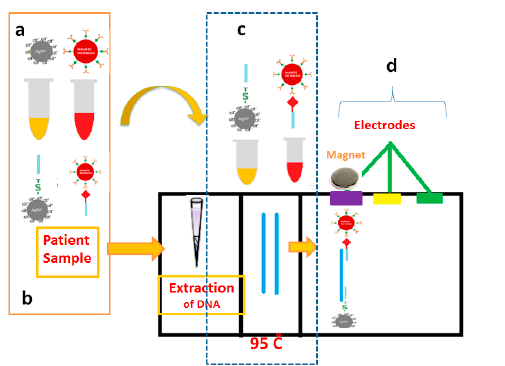
Figure 1. Modification of patient sample with AgNps and magnetic beads.